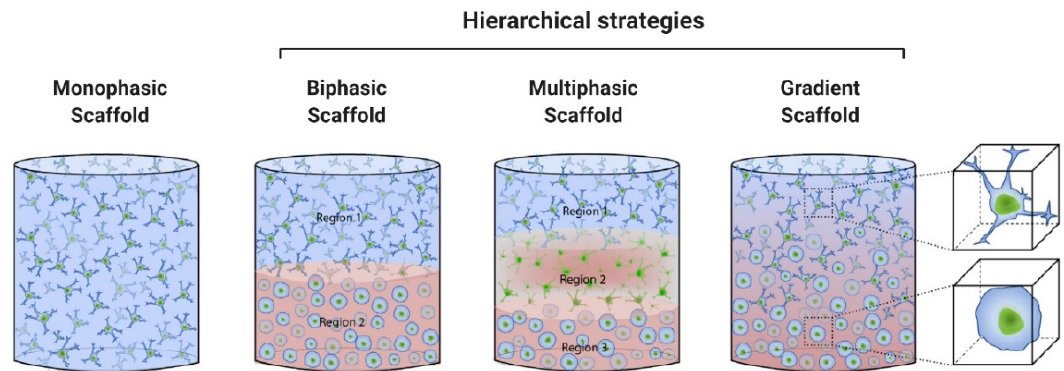
Figure 2. Schematic diagram of osteochondral tissue-engineered (OCTE) strategies used for the biofabrication of OC tissue replicates in vitro. Different approaches can be classified according to the number of layers and gradient properties of the designs: monophasic scaffolds are formed by a single homogeneous layer, while discrete gradient constructs can be bi- (two layers) or multiphasic (three or more layers). In the latter, each layer represents a specific region of the OC unit. Because multiphasic, discrete, scaffolds are associated with abrupt transitions between different phases, continuous gradient scaffolds have also been developed, in which a gradual transition between separate regions better emulates the native features of the joint. Adapted from [81] with permission from Elsevier. Copyright © 2016, Acta Materialia Inc. Published by Elsevier Ltd.